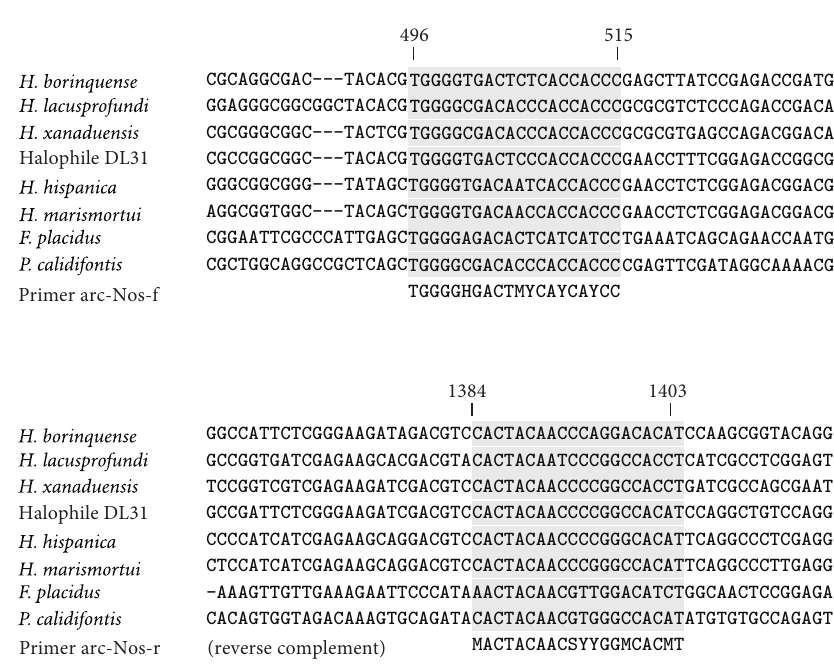
F1:Alignmentof nosZ genefragmentsfrom6membersoftheorderHalobacteriales, Ferroglobusplacidus, and Pyrobaculumcalidifontis , with binding sites of the novel primer pair arc-Nos-f/-r shaded. Reference positions given at the top refer to the nosZ gene of Halogeometricum borinquense .